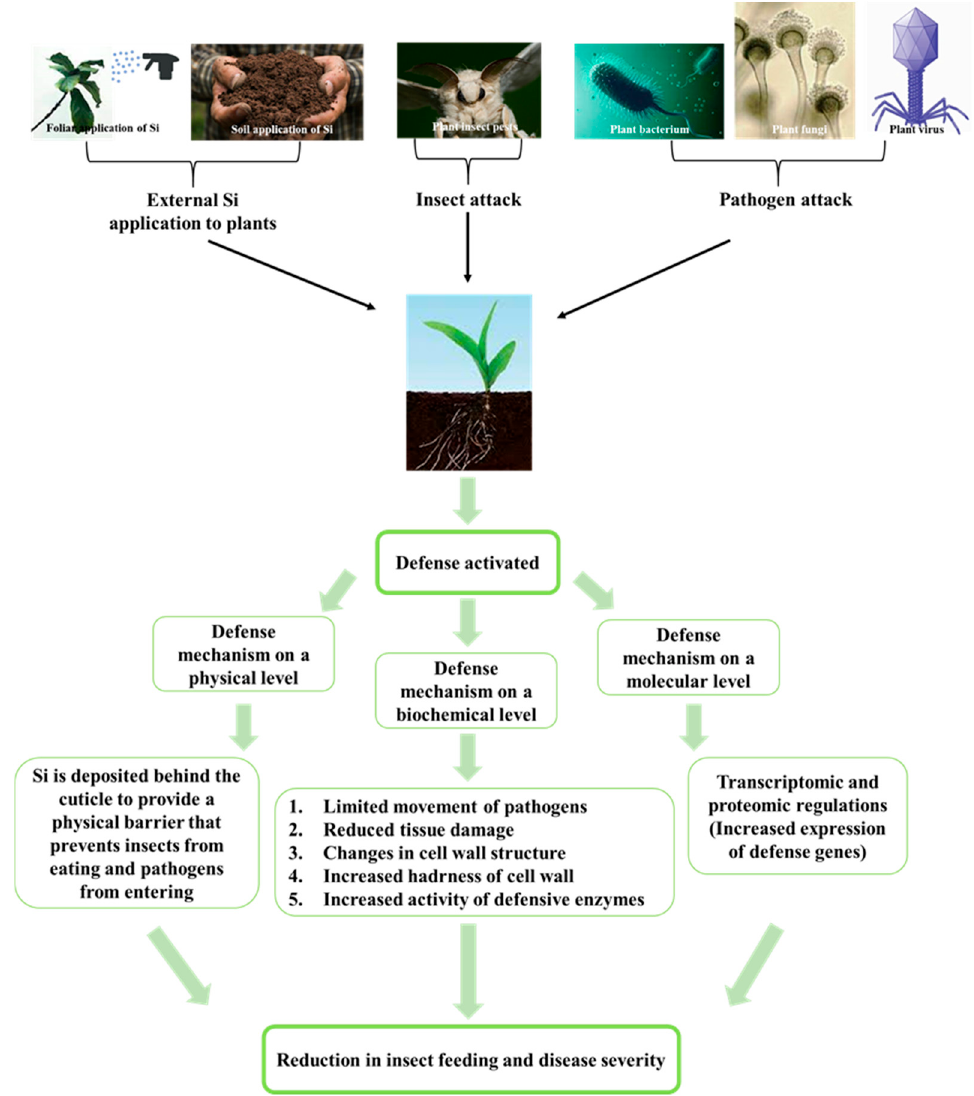
Figure 2. Silicon mediated plant defense against disease and insect pests.